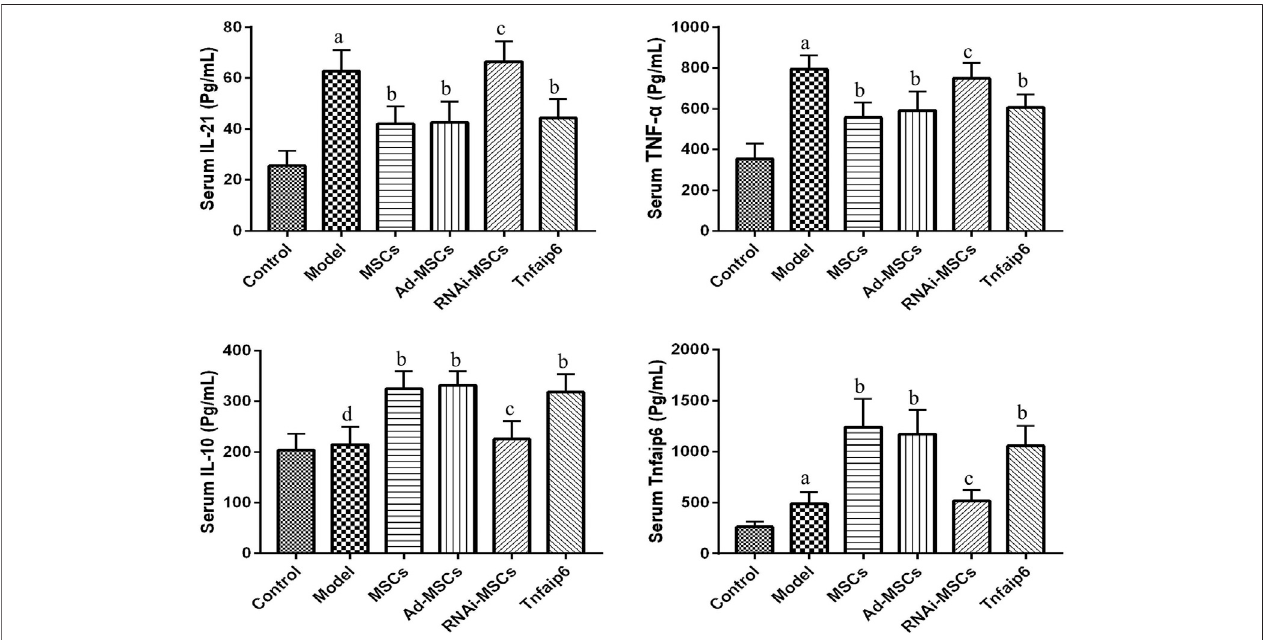
FIGURE8| SerumconcentrationsofIL-21,TNF- α ,IL-10,andTnfaip6inmicedeterminedbyELISA. a p < 0.05comparedtothecontrolgroup. b p < 0.05compared to the model group. c p > 0.05 compared to the model group. d p > 0.05 compared to the control group n ≥ 9 per group.